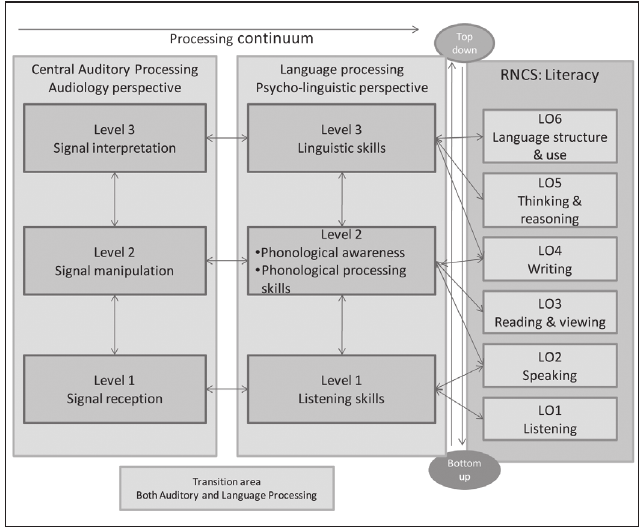
Fig. 1. The relationship between the three-levels of central auditory processing (Bel- lis, 2003) with language processing (Richards, 2004) and Literacy Outcomes (De- partment of Education,